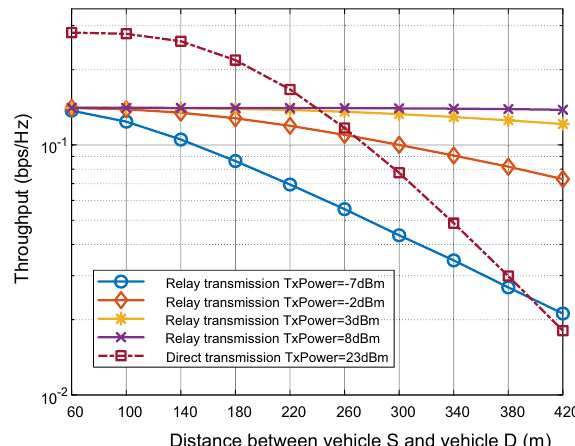
Fig. 14 Throughput performance without interference